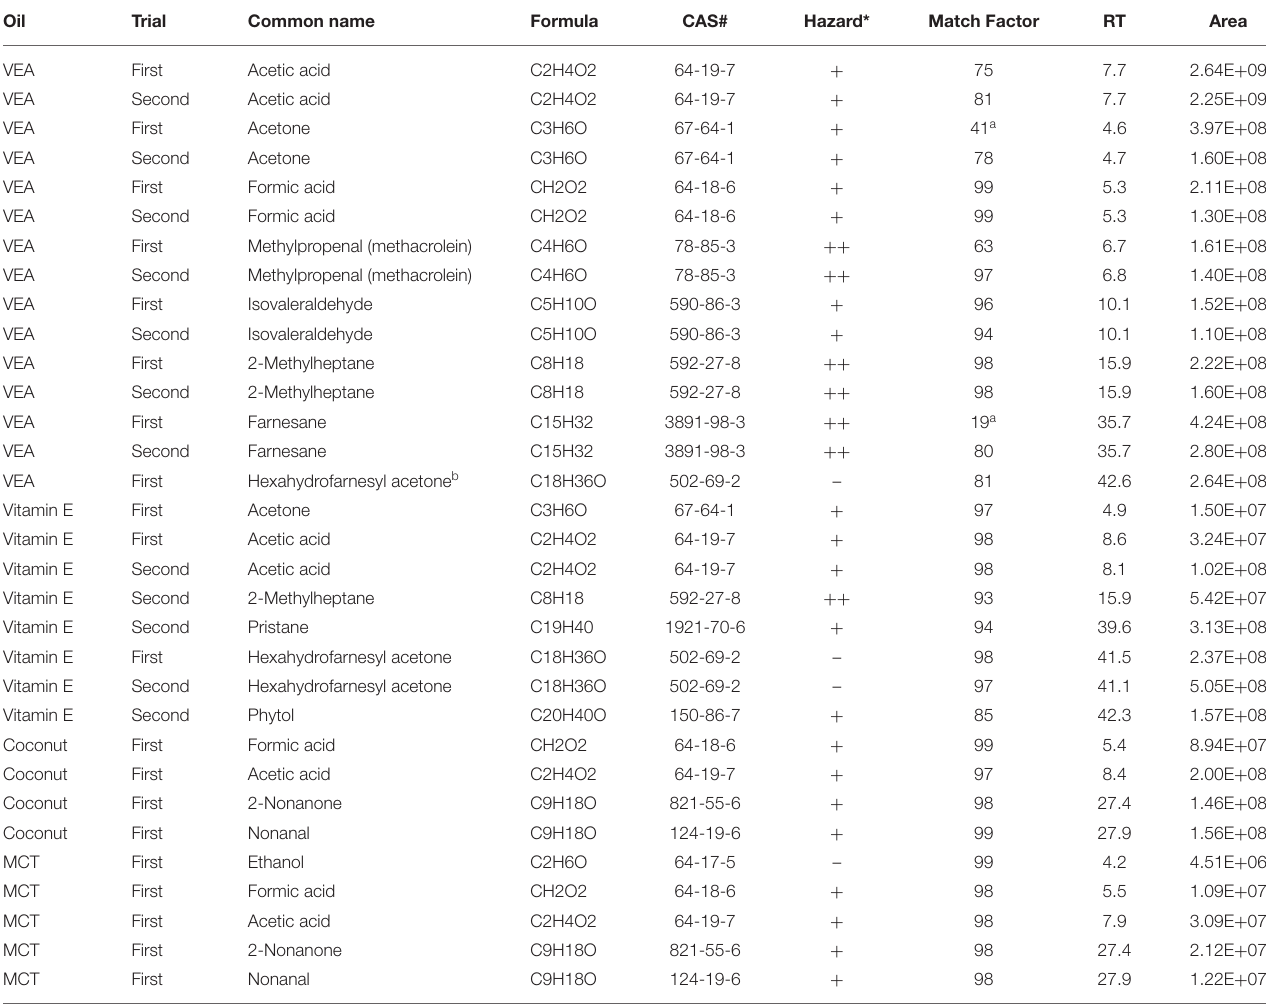
* Hazard assigned to groups using PubChem and Globally Harmonized System (GHS) classification hazard class with the highest hazard class being used for designation (i.e., higher hazard group can include lower hazard class): “–“ = Physical hazard only (H220, H225, H226), or environmental hazard only (H400, H410, H411, H412, H413), or no hazards noted in PubChem; “ + ” = Oral acute toxicity (H301, H302), skin corrosion/irritation (H314, H315, H316), skin sensitization (H317), serious eye damage/eye irritation (H319), respiratory tract irritation or narcotic effects from a single exposure with specific target organ toxicity (H335, H336), germ cell mutagenicity (H340, H341), carcinogenicity (H350, H351), reproductive toxicity(H360D,H360FD,H361,H361d,H361f),and/orrepeatedexposurewithspecifictargetorgantoxicity(H372,H373);and“ ++ ” = Aspirationhazard(H304)and/oracuteinhalation toxicity (H330, H331, H332, or H333). a These low match factors were a result of noisy mass spectrum compared to NIST11 library. b identified as 1,2-epoxynonadecane, CAS#67860- 04-2, in second trial but not confirmed with retention time matching (see Supplementary Table 3 ). Common name taken from Chemspider (http://www.chemspider.com/). Area is the component area after mass spectral deconvolution. Match factor is the automated NIST mass spectral quality factor ranging from 0 to 100 with higher numbers indicating a better match with standard spectra. RT is the retention time of the deconvoluted peak in